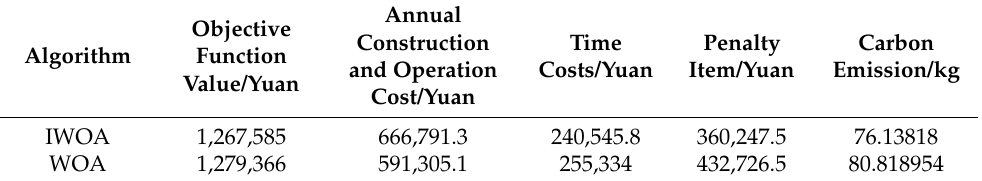
Table 8. The cost comparison between the IWOA and WOA to solve the location model.